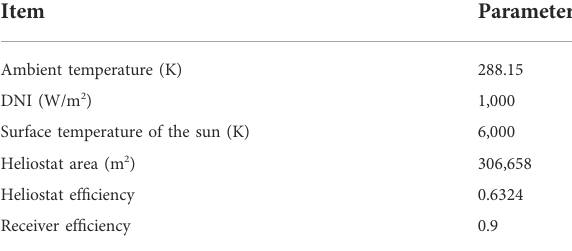
TABLE 2 Key parameters of the solar fi eld (Jiang et al., 2022).